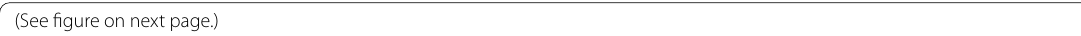
Fig. 5 a Representative Western blot images of TLR4 in the control group and the agomir treatment group at day 3, week 1, week 2 and week 4 after pilocarpine-induced SE. b Quantification of immunoblot intensity in ( a ) (* P < 0.05 versus control group; n 4 per group). c = Representative Western blot images of TLR4 in the control group and the antagomir treatment group at day 3, week 1, week 2 and week 4 after pilocarpine-induced SE. d Quantification of immunoblot intensity in ( c ) (* P < 0.05 versus control group; n 4 per group). e Behavior analysis of = pilocarpine-induced SE showed that the degree of seizures in the antagomir group at various time points (10 min, 20 min, 30 min) was significantly higher than that of the vehicle group, while this increase was reversed in the antagomir TAK-242 group. f The latency to SE in the antagomir + group, antagomir TAK-242 group and vehicle group (* P < 0.05 versus vehicle group; n 8 per group). g Representative Western blots of TLR4 in + = the different groups. h Quantification results showed that the antagomir increased the expression of both IL-6 and TNF-α, whereas this increase was reversed in the antagomir TAK-242 group (* P < 0.05 versus vehicle group; n 8 + =